Question: According to the figure, is the described quantity increasing or decreasing?
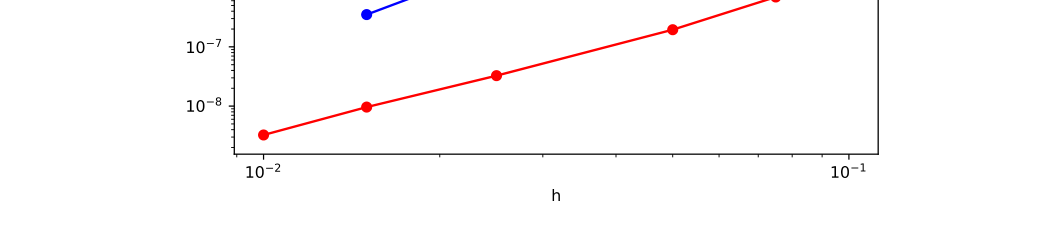
Answer: decreasing